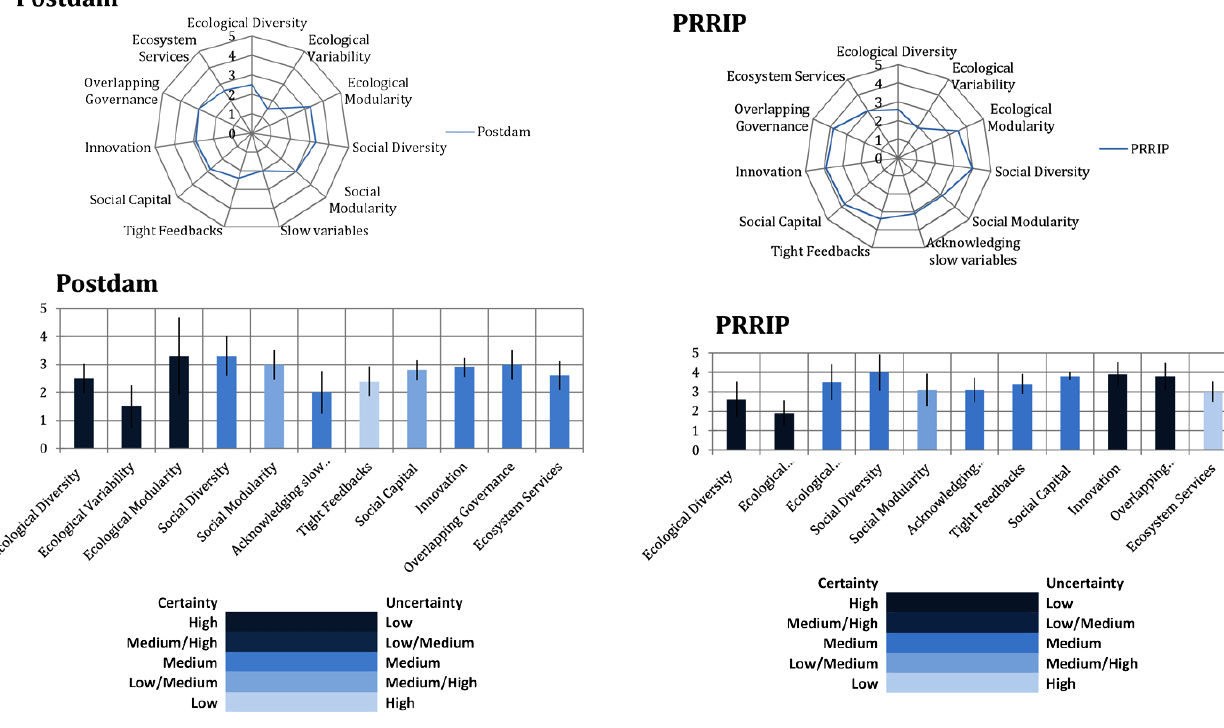
Fig. 3 . Resilience of the central Platte River social-ecological system in regard to Walker and Salt’s (2006) nine resilience properties and level of uncertainty associated with each property during the time period after the Kingsley Dam.